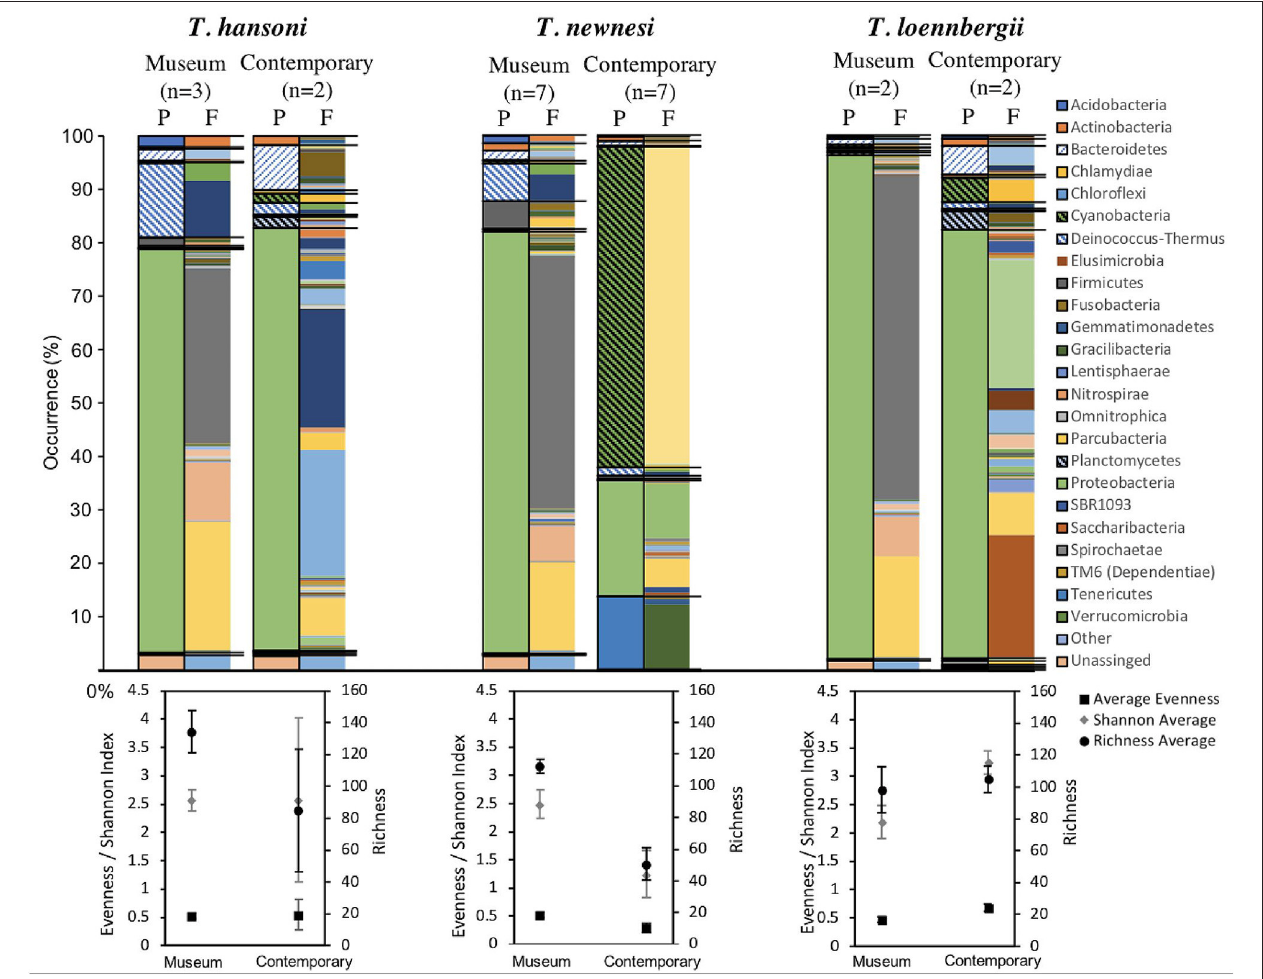
FIGURE 4 | Taxonomic information of the microbiome of Trematomus hansoni , T. newnesi and T. loennbergii . The abundance of each microbial taxonomic group is represented in bar plots on phylum (P) as well as family (F) level for museum and contemporary samples of each fish species. Phyla are separated by black lines drawn through both P and F barplots. The taxa listed in the family level plots are positioned as in the phylum level plots (i.e., they correspond to the same phyla). Within the bar plots the phylum of the family plots correspond to the same position as of the one from the phylum plots. Diversity plots for species evenness, Shannon index and species richness of museum and contemporary samples are presented for each species below the taxonomic